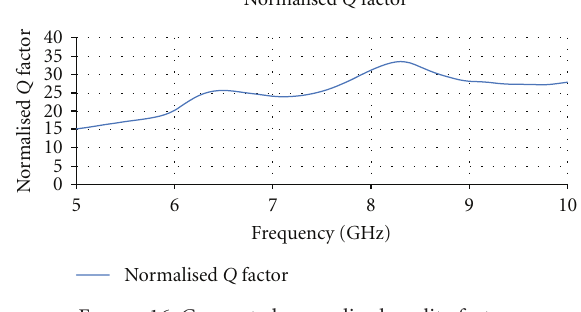
Figure 16: Computed normalized quality factor.